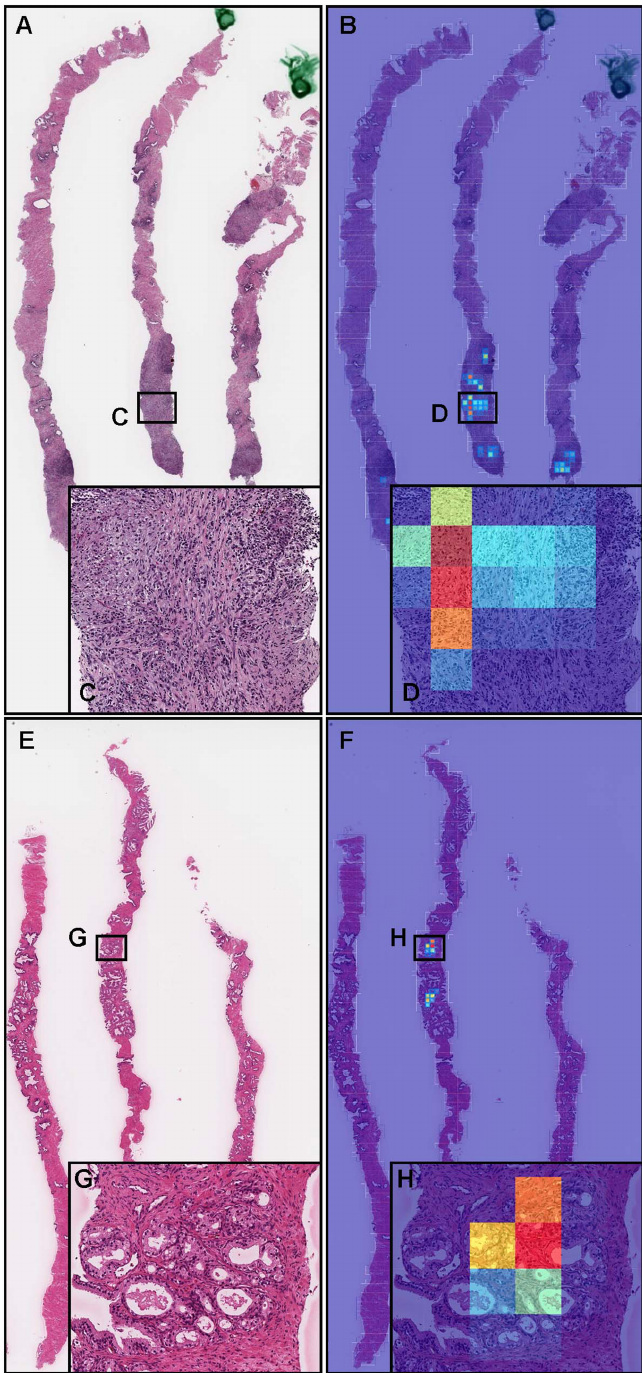
Figure 4. Representative examples of prostate adenocarcinoma false positive prediction outputs on cases from the needle biopsy test sets. Histopathologically, ( A , E ) are benign (non-neoplastic) lesions. The heat map images ( B , F ) exhibit false positive predictions of adenocarcinoma ( D , H ) using transfer learning from the colon poorly differentiated adenocarcinoma model (TL-colon poorly ADC- 2 (20 × , 512)). Infiltration of chronic inflammatory cells including histiocytes, lymphocytes, and plasma cells ( C ) would be the primary cause of the false positives due to a morphology analogous to adenocarcinoma cells’ infiltration ( D ). Areas where prostatic hyperplasia ( G ) would be the primary cause of false positives ( H ). The heat map uses the jet color map where blue indicates low probability and red indicates high